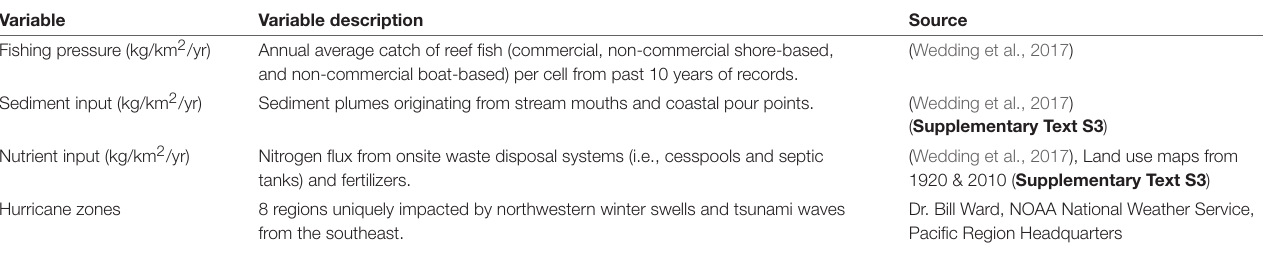
TABLE 1 | Spatially-explicit stressors used to force scenario simulations in